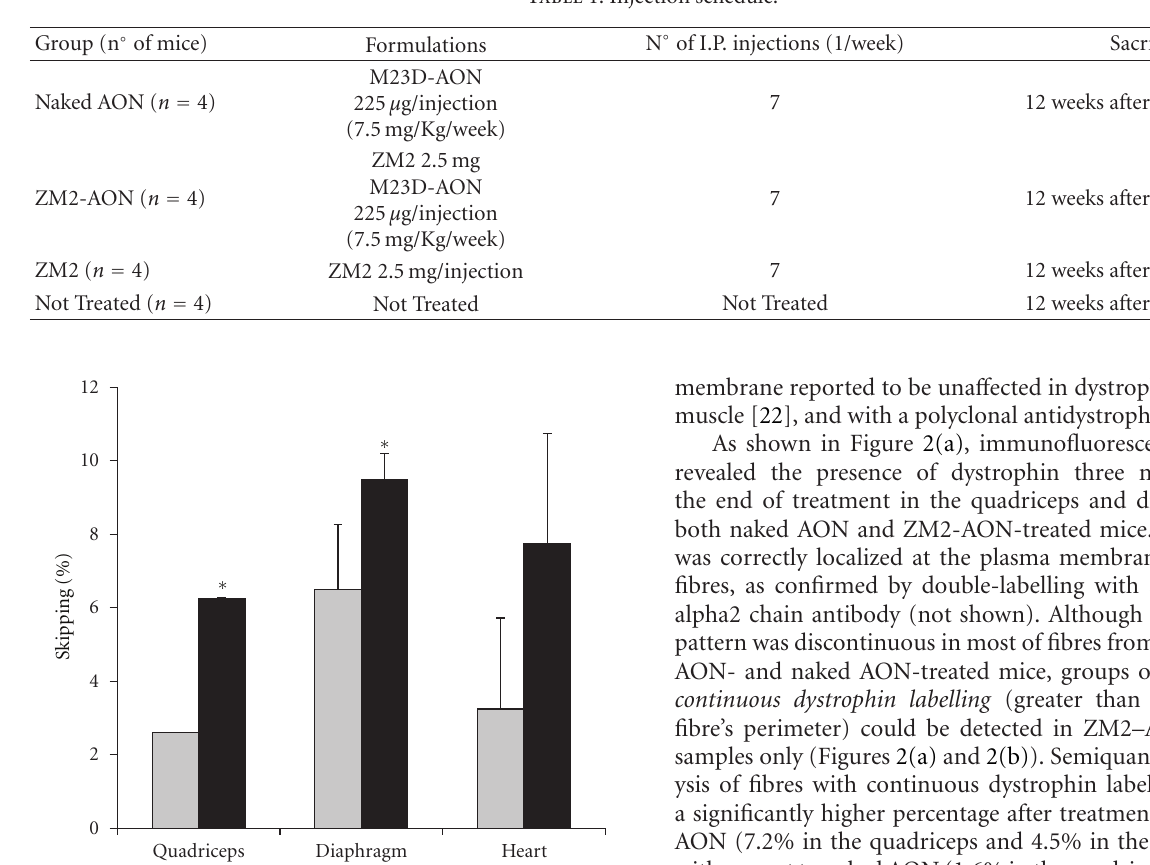
Table 1: Injection schedule.